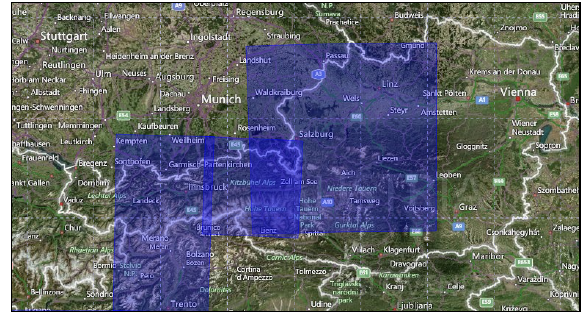
Figure 1. Sentenel-2 data coverage of Austria Reference data which Sentinel-2 data of Austria was compared to is Geoland Basemap Orthophoto of Austria (data source: LandTirol - data.tirol.gv.at). It is a color image acquired with